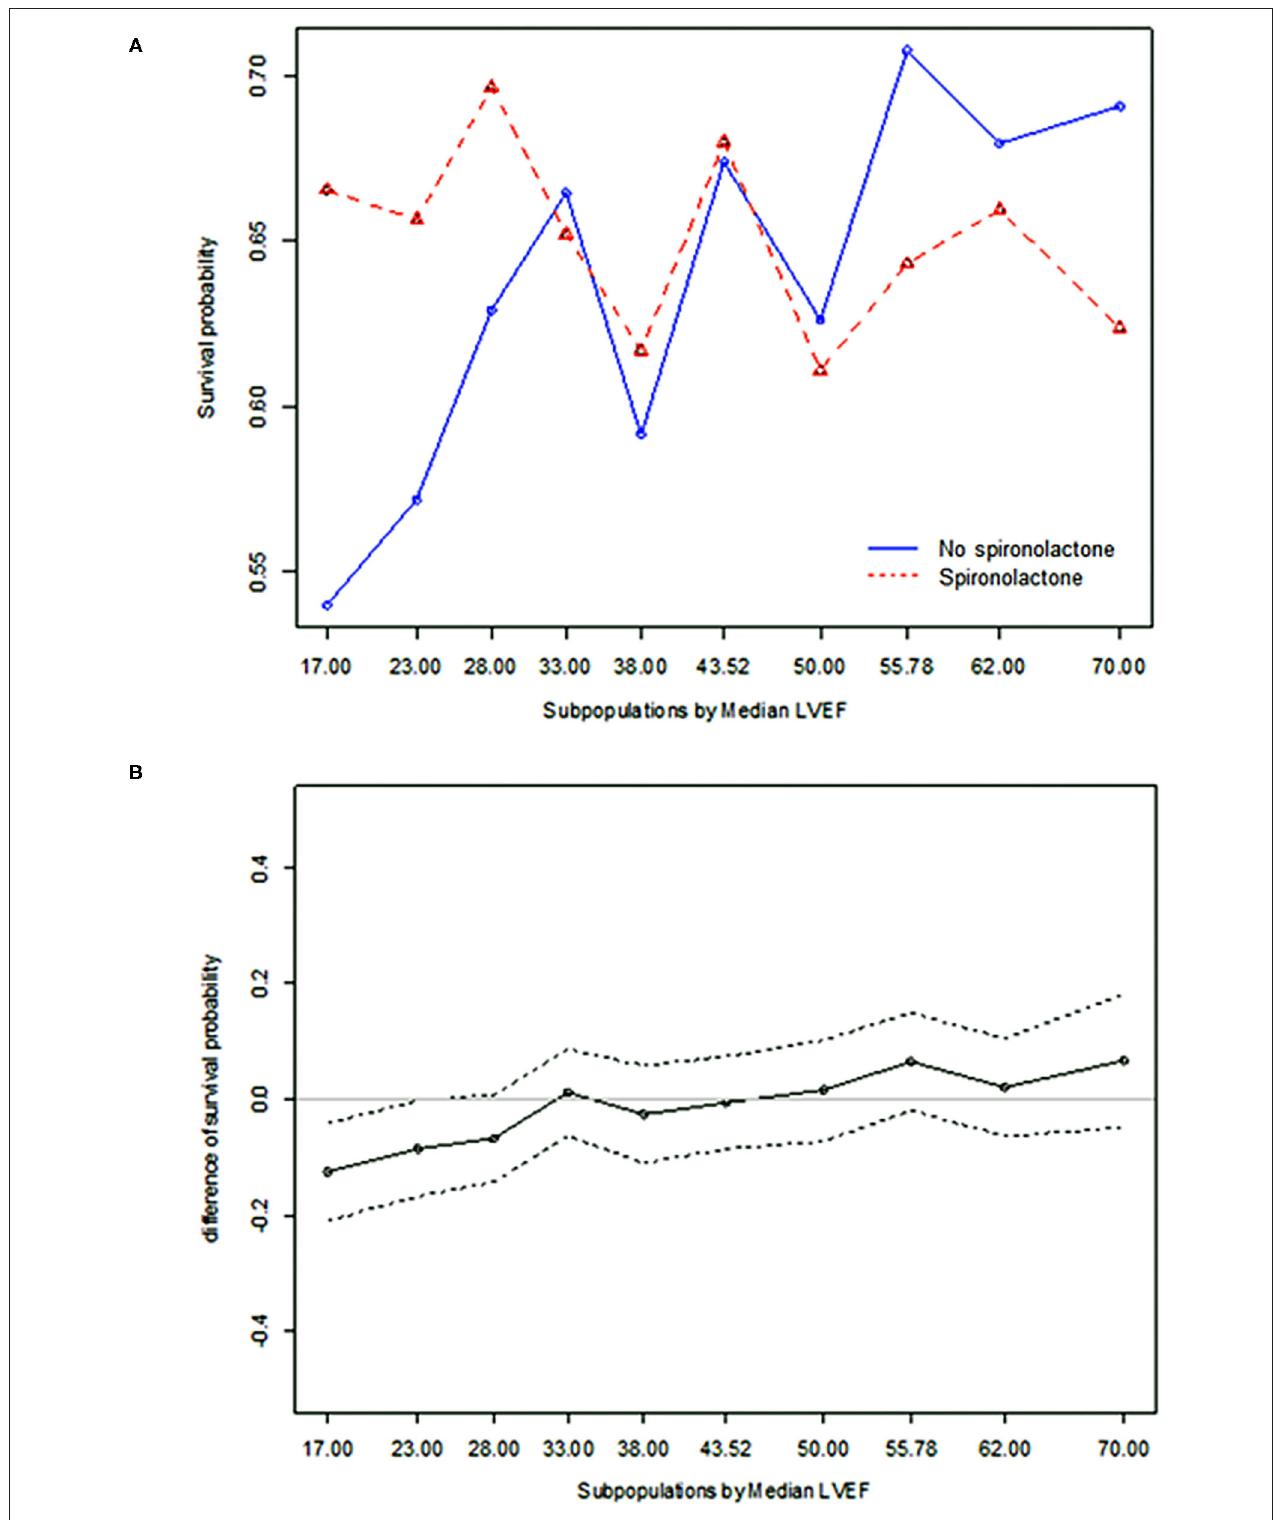
FIGURE 2 | Subpopulation treatment effect pattern plot analysis of the treatment effect of spironolactone as measured by (A) 3-year all-cause mortality, (B) difference in 3-year all-cause mortality.